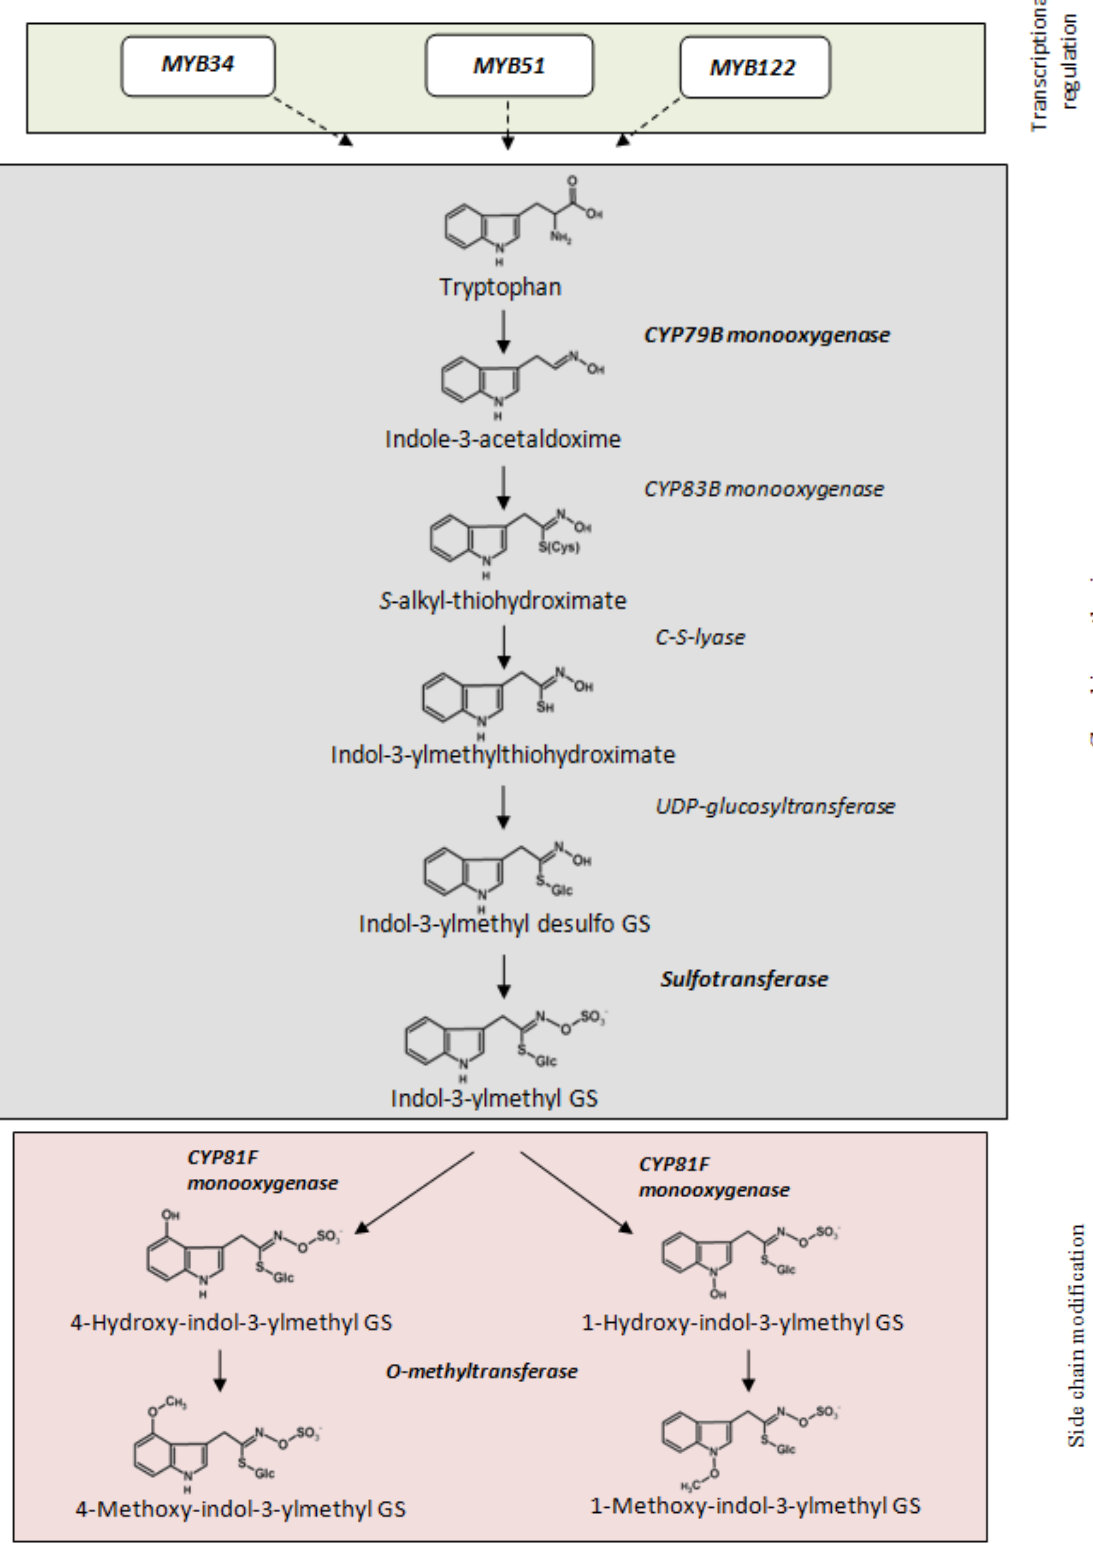
Figure 2. Biosynthesis of indole glucosinolates in Arabidopsis. Transcriptional regulators, enzymatic steps involved in core biosynthesis and side chain modification are shown. Steps analyzed in more detail on gene expression level are marked in